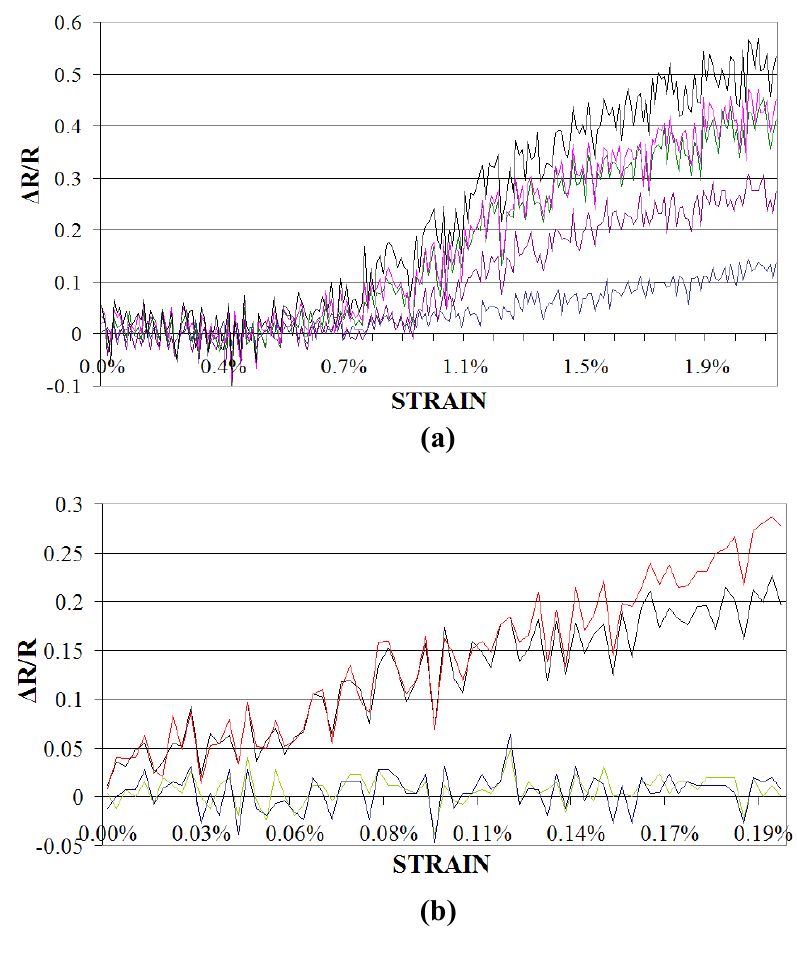
Figure 5. Electrical resistance variation during tensile strength tests on different yarn and filament substrates coated with 35 wt.-% carbon black solution. (a) Cotton spun yarns; (b) Polyamide monofilaments; (c) Polyethylene